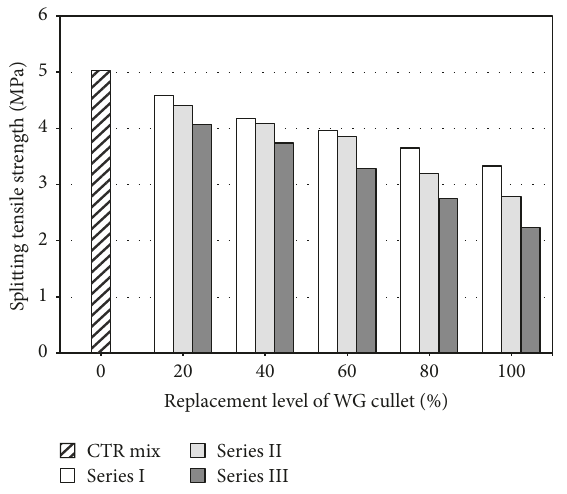
Figure 5: Splitting tensile strength of SCC mixtures at 28 days with respect to WG cullet content.